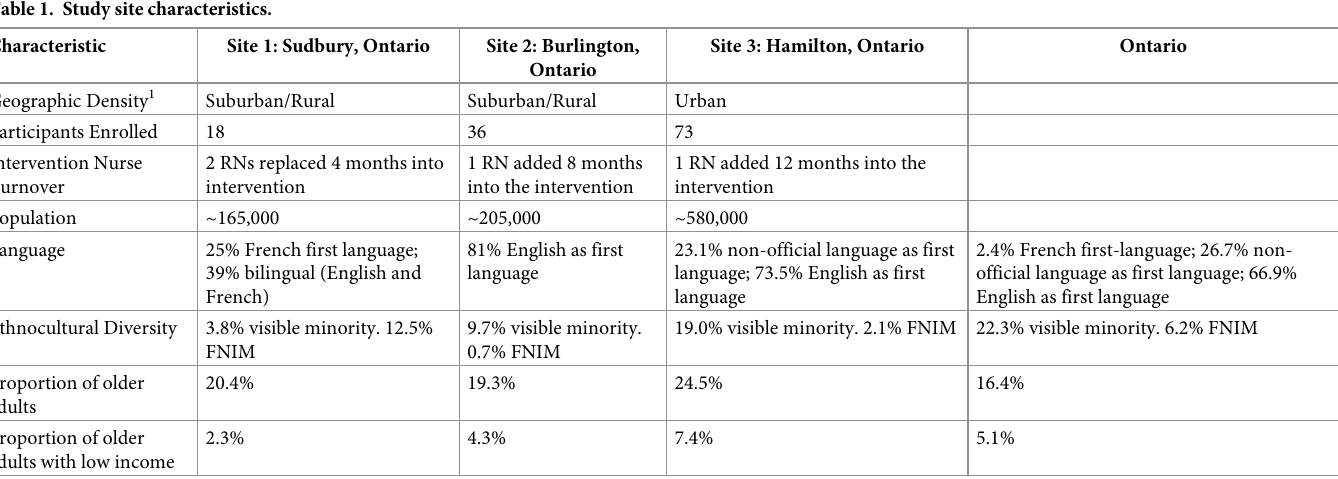
Table 1. Study site